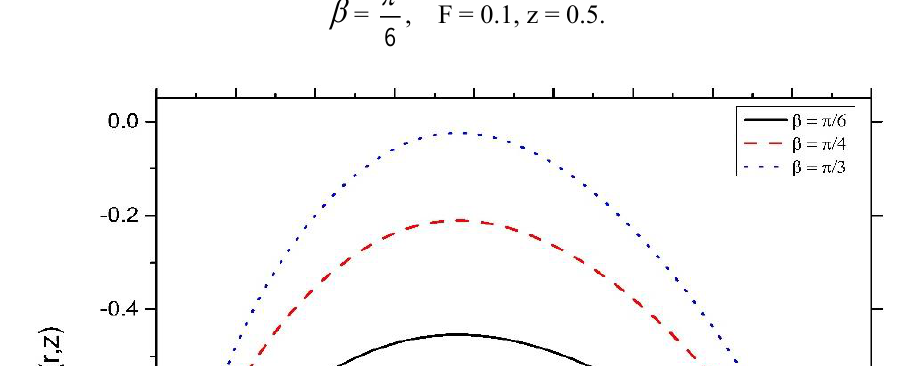
 ) contrary to Q with 